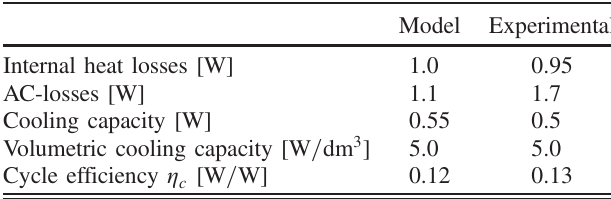
TABLE III. Mathematical model verification.